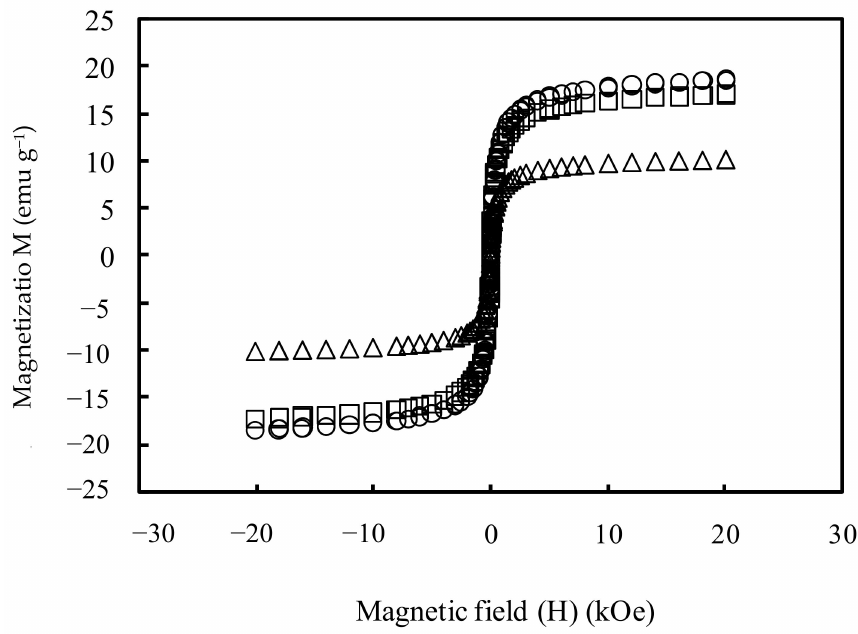
Figure 2. Magnetization curves ( M vs. H ) of M-PVAC-IDA particles.